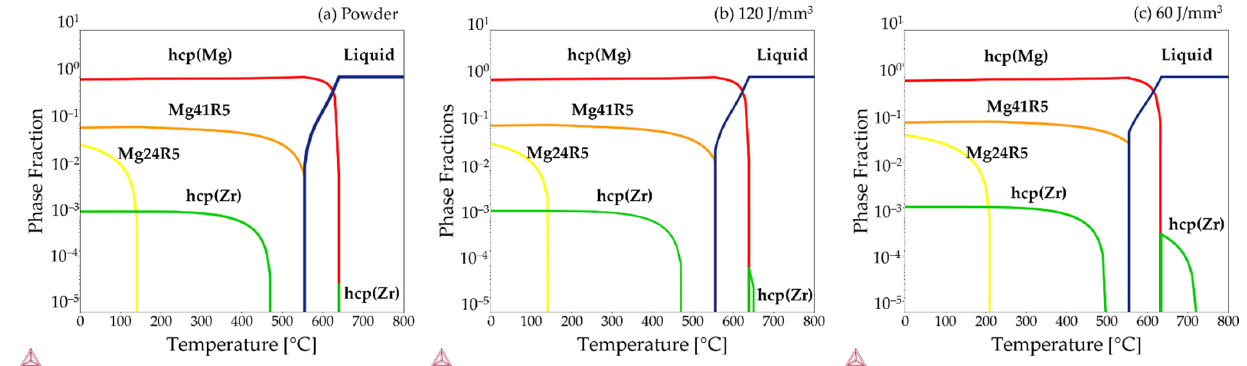
Figure 6. Calculated property diagrams showing the equilibrium phase fraction as a function of temperature for the alloying content given in Table 3 for ( a ) the powder, ( b ) the sample printed with ED = 120 J/mm 3 , and ( c ) the sample printed with ED = 60 J/mm 3 , using the Thermo-Calc TCS Mg-based alloys Database version 5.0 [49,50].